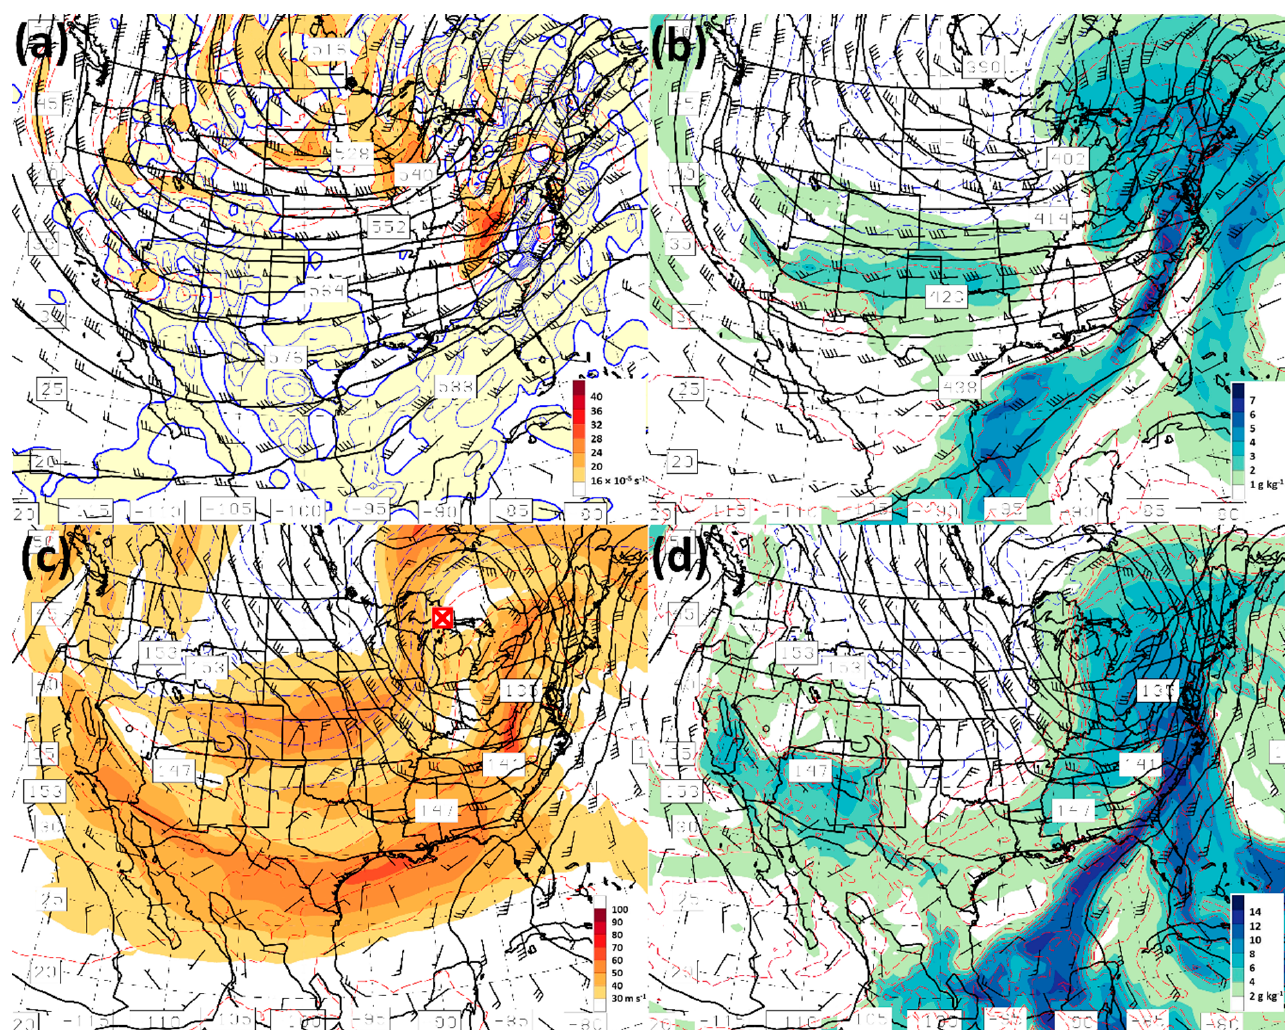
Figure 9. As in Figure 3, except GFS − analyzed fields valid at 1200 UTC 13 April 2020 of: ( a ) 500 hPa level geopotential height (dam, solid black contours), absolute vorticity × 10 − 5 (s − 1 , shading and red dashed contours), and wind vectors (kt) and 700 hPa level rising motion × 10 − 3 (hPa s − 1 , vanilla shading and blue solid contours); ( b ) 600 hPa level geopotential height (dam, solid black contours), mixing ratio (g kg − 1 , shading), equivalent potential temperature (K, final blue (first red) dashed contour value is 304 K (310 K)), and wind vectors (kt); ( c ) 850 hPa level geopotential height (dam, solid black contours) and wind vectors (kt) and 1000-500 hPa layer thickness (dam, final blue (first red) dashed contour value is 540 dam (546 dam)), and 300 hPa level wind speed (m s − 1 , shading); and ( d ) 850 hPa level geopotential height (dam, solid black contours), mixing ratio (g kg − 1 , shading), wind vectors (kt), and equivalent potential temperature (K, final blue (first red) dashed contour value is 280 K (286 K)). Red cross-square symbol in panel ( c ) represents the locally dominant 850 hPa level cyclone